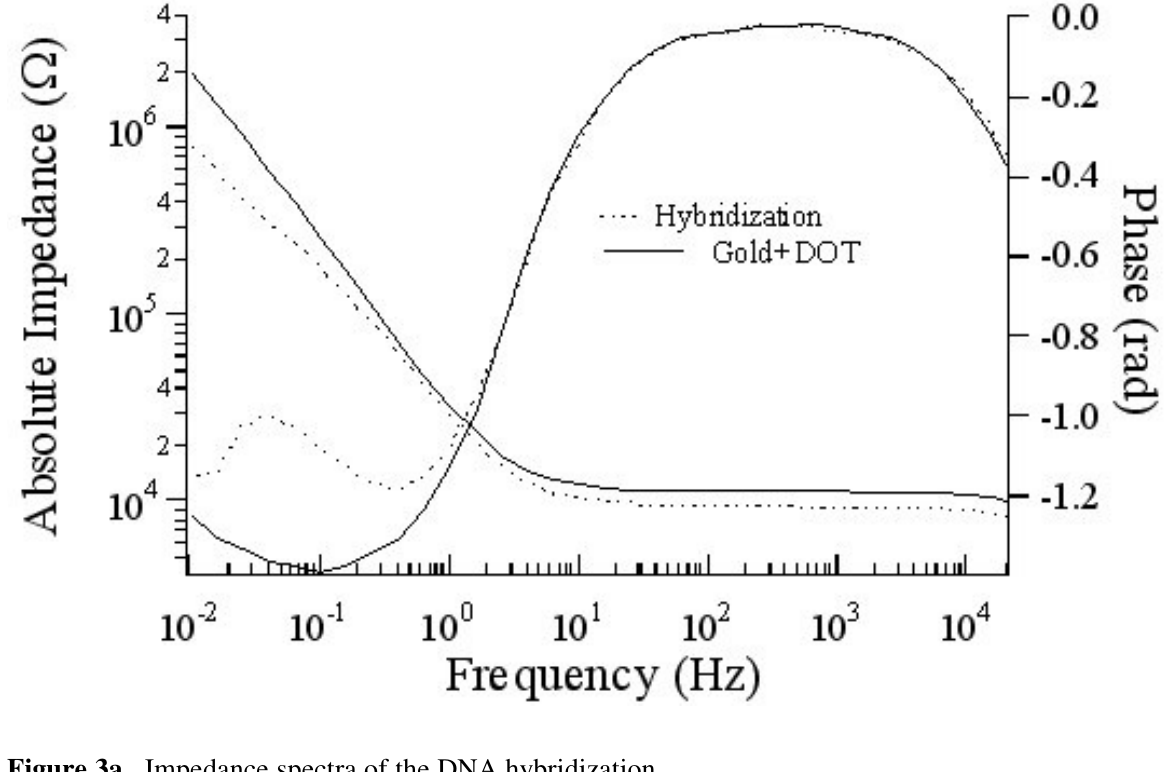
Figure 3a. Impedance spectra of the DNA hybridization.